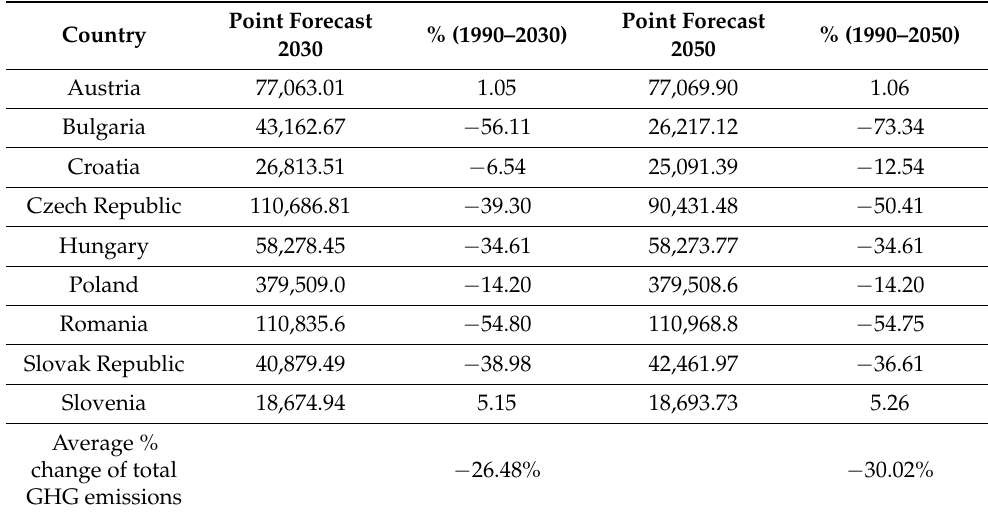
Table 5. Forecasts for GHG emissions in nine CEE countries over 2019–2030 and 2019–2050. Point Country